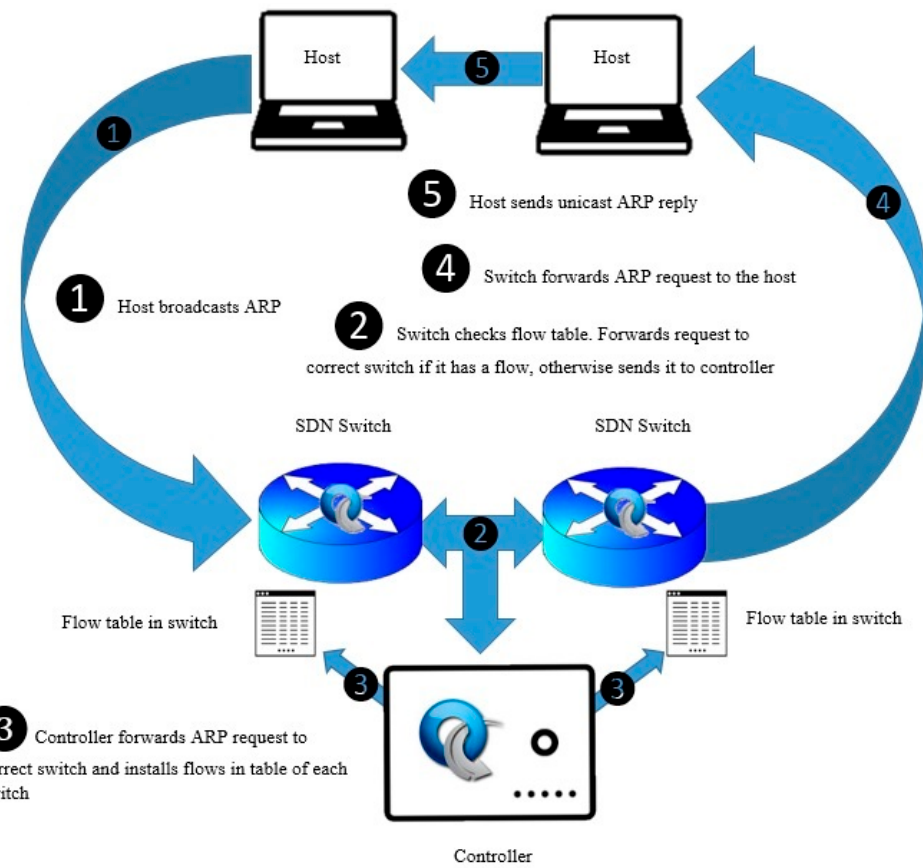
Figure 2. Regular ARP in SDN (Software Defined Networking).